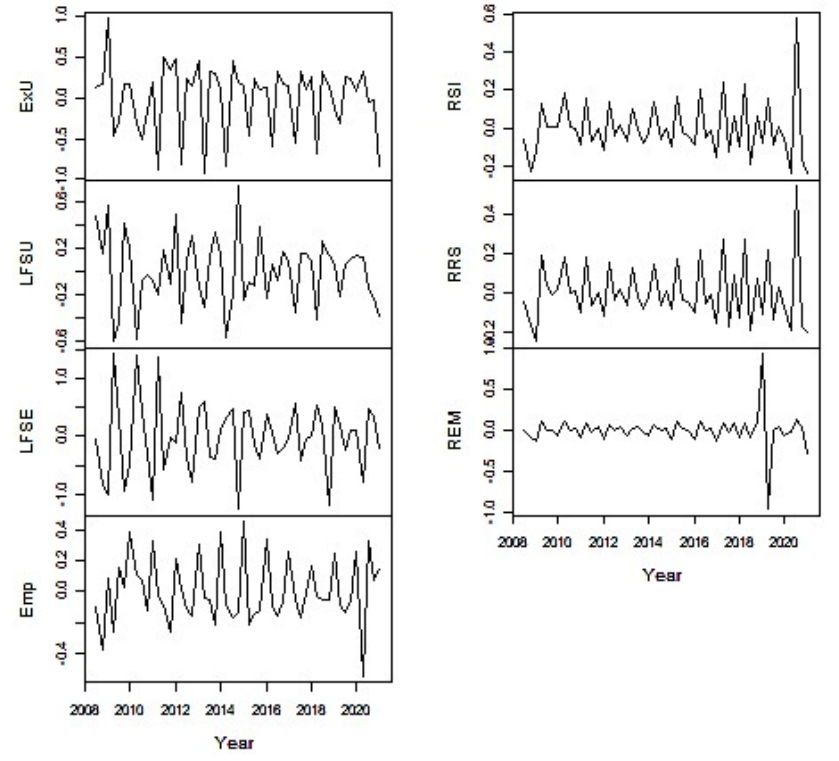
Figure 6. Stationary time